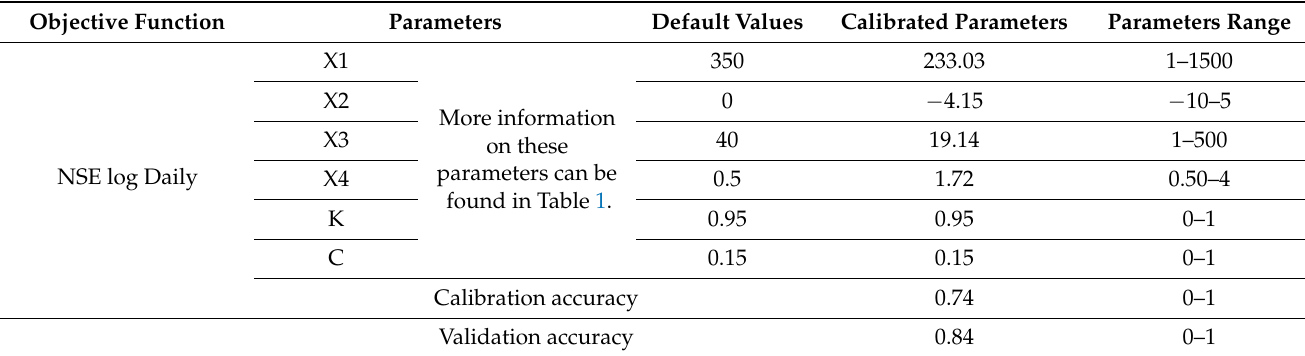
Table 7. Calibrated parameters of the GR4J rainfall–runoff